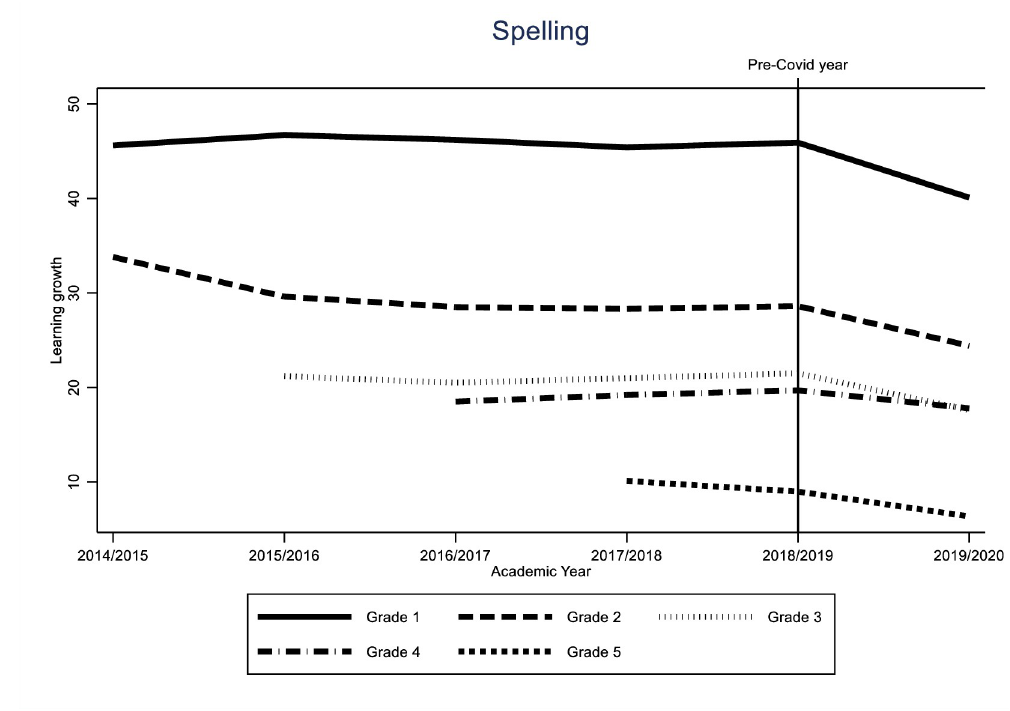
Fig 6. Trends in learning gain over